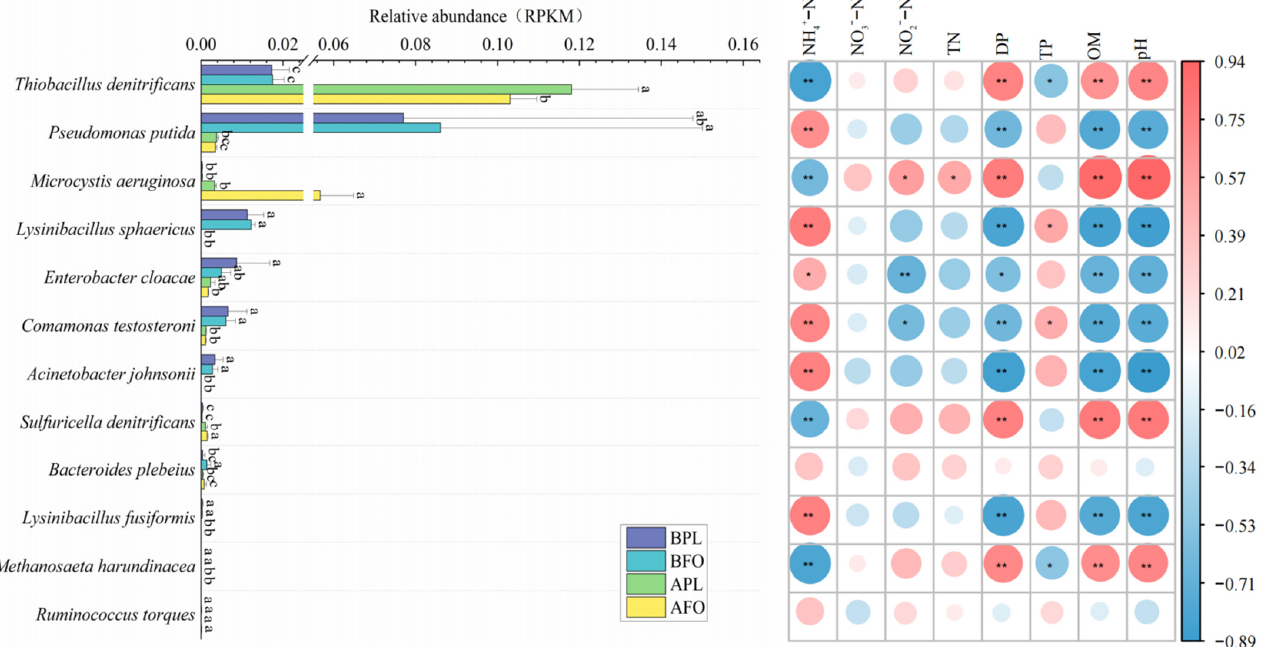
Figure 7. The relative abundances of microorganisms annotated to the nitrogen cycle gene family. Different letters designate remarkable differences between different samples ( p < 0.05, LSD test, n = 4). The heat map on the right indicates the correlation between microbial abundance and environmental factors. The size of the circle indicates the magnitude of the correlation coefficient, and the color indicates its positive or negative correlation. ** represents significant correlation at 0.01 level, n = 16; * represents significant correlation at 0.05 level, n = 16.